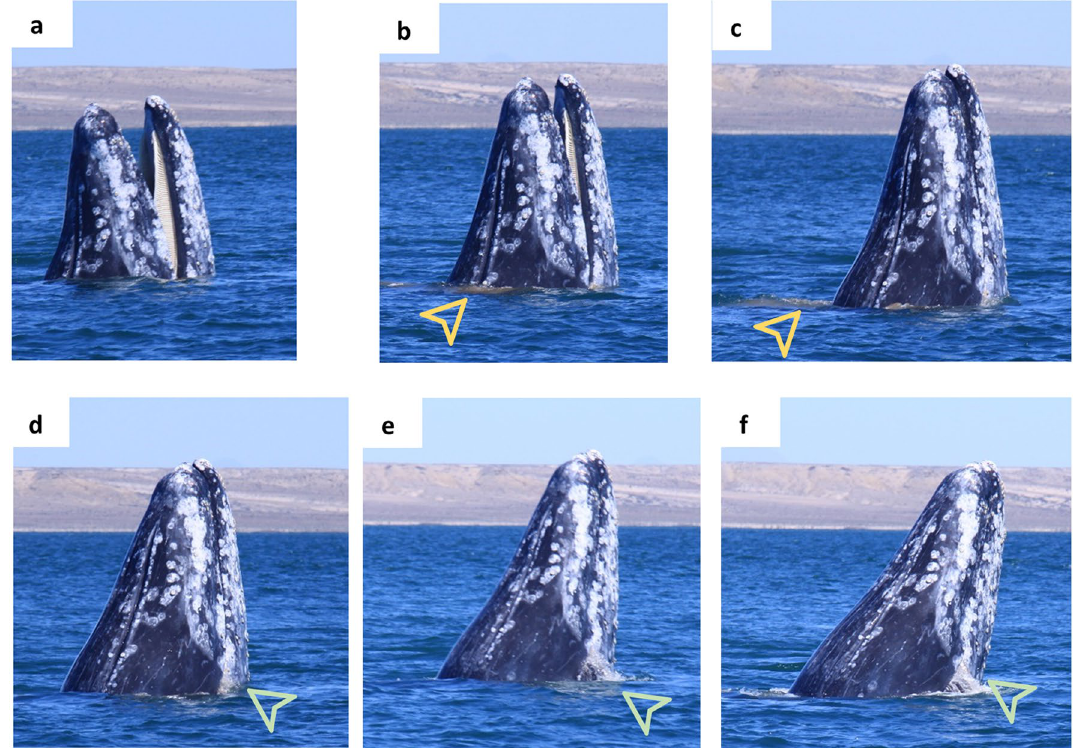
Figure 6. Photographic evidence of a gray whale feeding in Ojo de Liebre Lagoon. The organism emerged with open mouth ( a , b ), to then close it ( c ) and expel water (from d to f , green arrow). The animal then tilted back ( e , f ), most probably to better swallow the food. Sediment particles were visible around the whale body after its emersion ( b , c , yellow